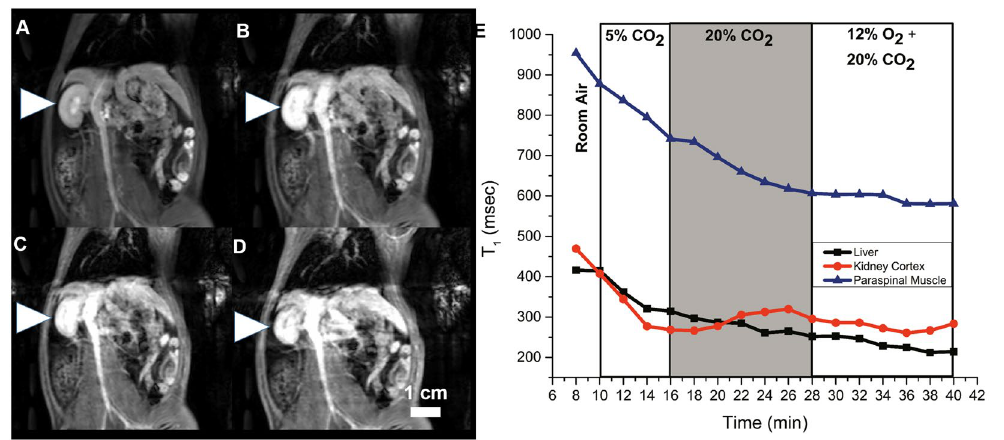
Figure 4. Dynamic MR imaging of blunting effect of mild hypercapnia-mediated vasodilatation on subsequent vasoconstriction capacity. The kidney is shown on T 1 -weighted images acquired at the end of successive 8–12 minute gas challenges in a rat subjected to the following sequence: normoxia ( A ) → mild hypercapnia (5% CO 2 ) ( B ) → severe hypercapnia (20% CO 2 ) ( C ) → hypoxic hypercapnia (12% O 2 + 20% CO 2 ) ( D ). Corresponding temporal evolution of changes in T